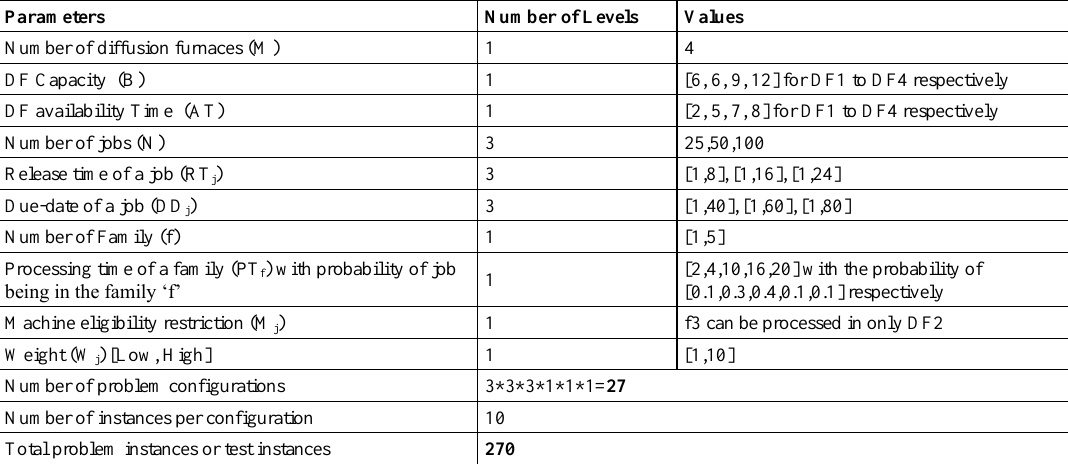
Table 2. A summary of proposed experimental design for